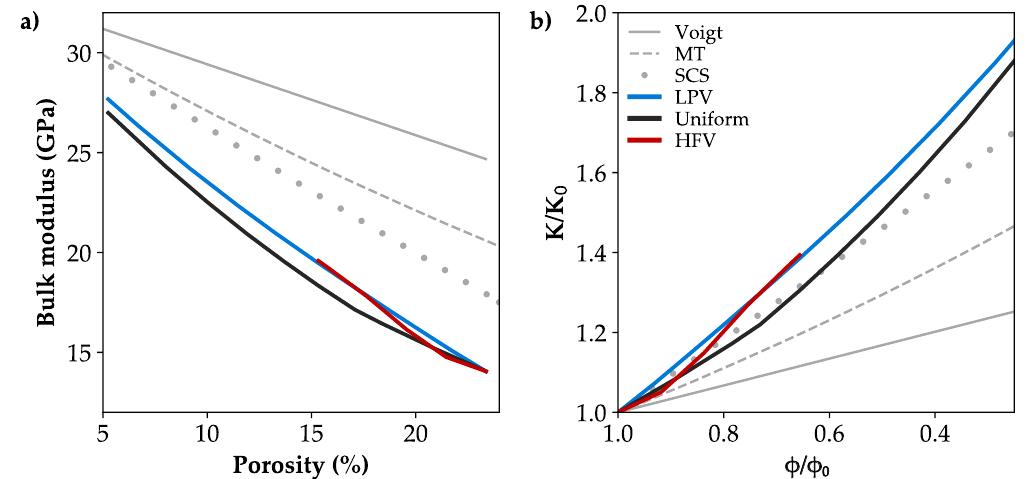
Figure 10. ( a ) Simulated increase in bulk moduli due to preferential precipitation at high flow velocity magnitudes (HFV, red), low flow velocity magnitudes (LFV, blue) and a uniform grain coating (black) compared to analytical solutions (grey) as the Voigt average, Mori–Tanaka approach (MT), and the Self-Consistent Scheme (SCS). ( b ) Stiffening trend by normalisation of bulk moduli (K) and porosity ( φ